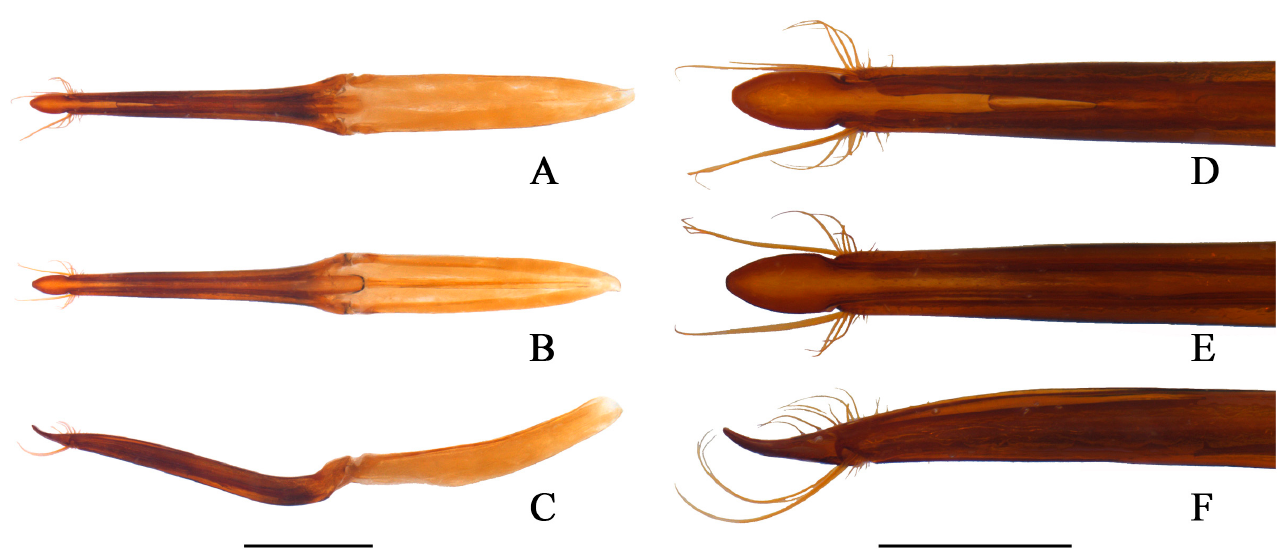
Figure 3. Osphya sinensis sp. n. ( A – C ) the whole of the aedeagus; ( D – F ) the apical half part of the aedeagus. ( A , D ) dorsal view; ( B , E ) ventral view; ( C , F ) lateral view. Scale bars ( A – C ) 1.0 mm; ( D – F ) 0.5